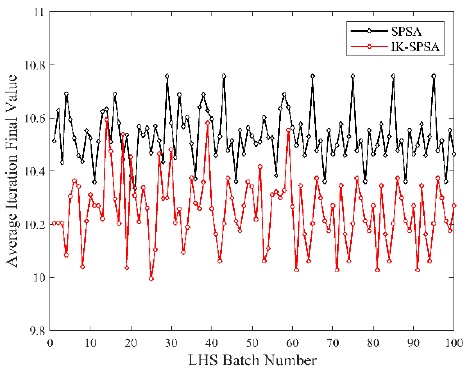
Figure 19. Average iteration final value distribution at the same initial point .